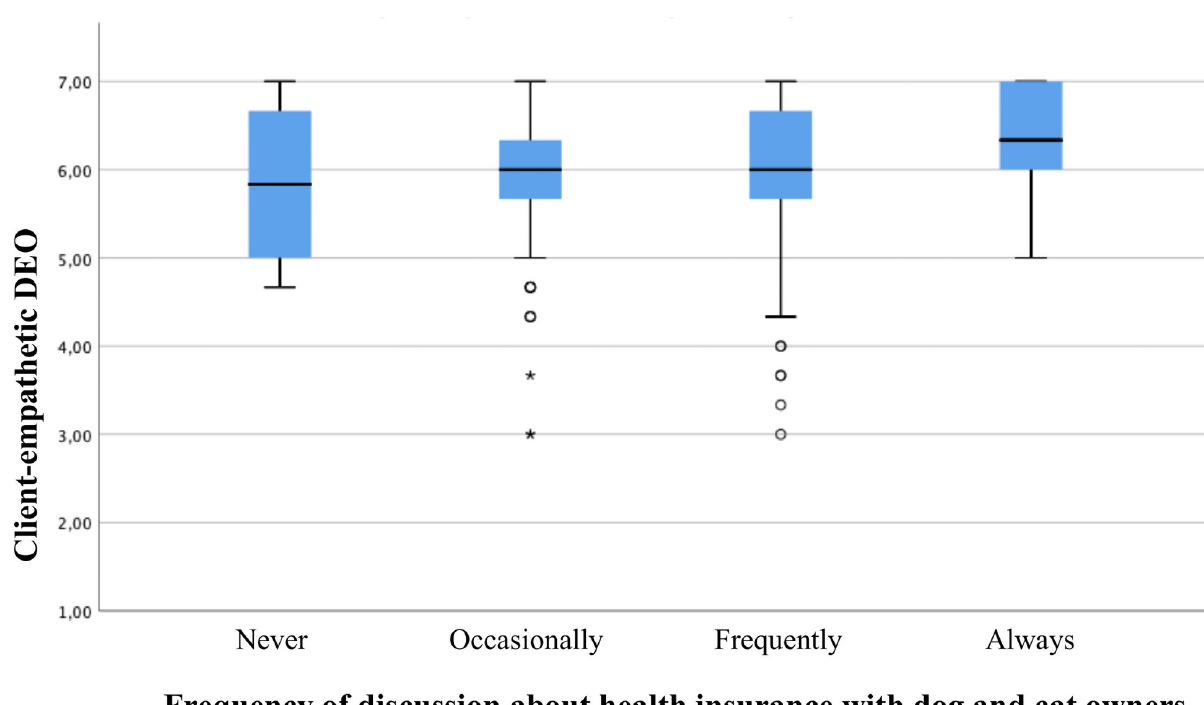
Fig 4. Box plots showing level of client-empathetic DEO with respect to frequency of discussion about health insurance for UK veterinarians. In the box plots, the boundary of the box closest to zero indicates the first quartile, the thick black within the box marks the median, the boundary of the box farthest from zero indicates the third quartile. Whiskers above and below the box indicate 10th and 90th percentiles. Points and asterisk (extreme outliers) below the whiskers indicate outliers outside the 10th and 90th percentiles.